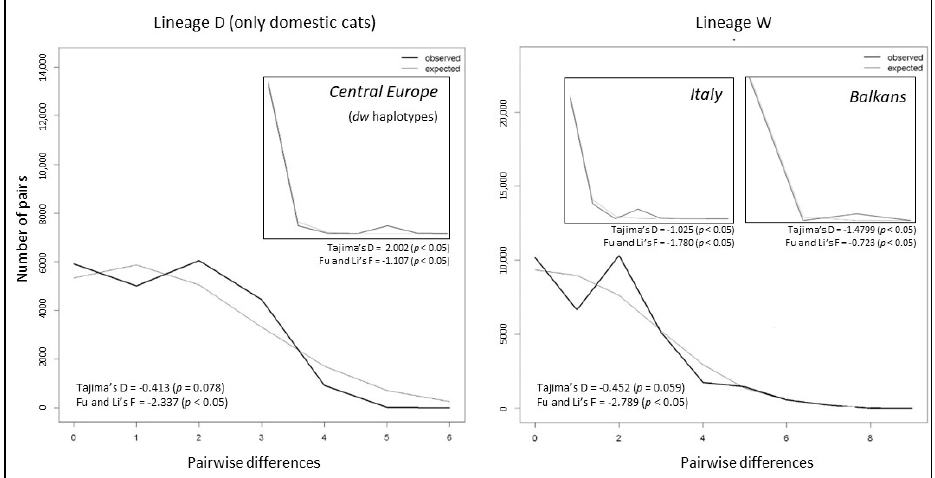
Figure 4. Mismatch distribution plots computed using haplogroups showing significant values of Tajima’s D and Fu and Li’s F indexes. Larger plots show mismatch distribution results about lineage D (considering only domestic cat samples) and lineage W. Smaller plots show mismatch distribution results about different macro-regions within each of the two lineages.